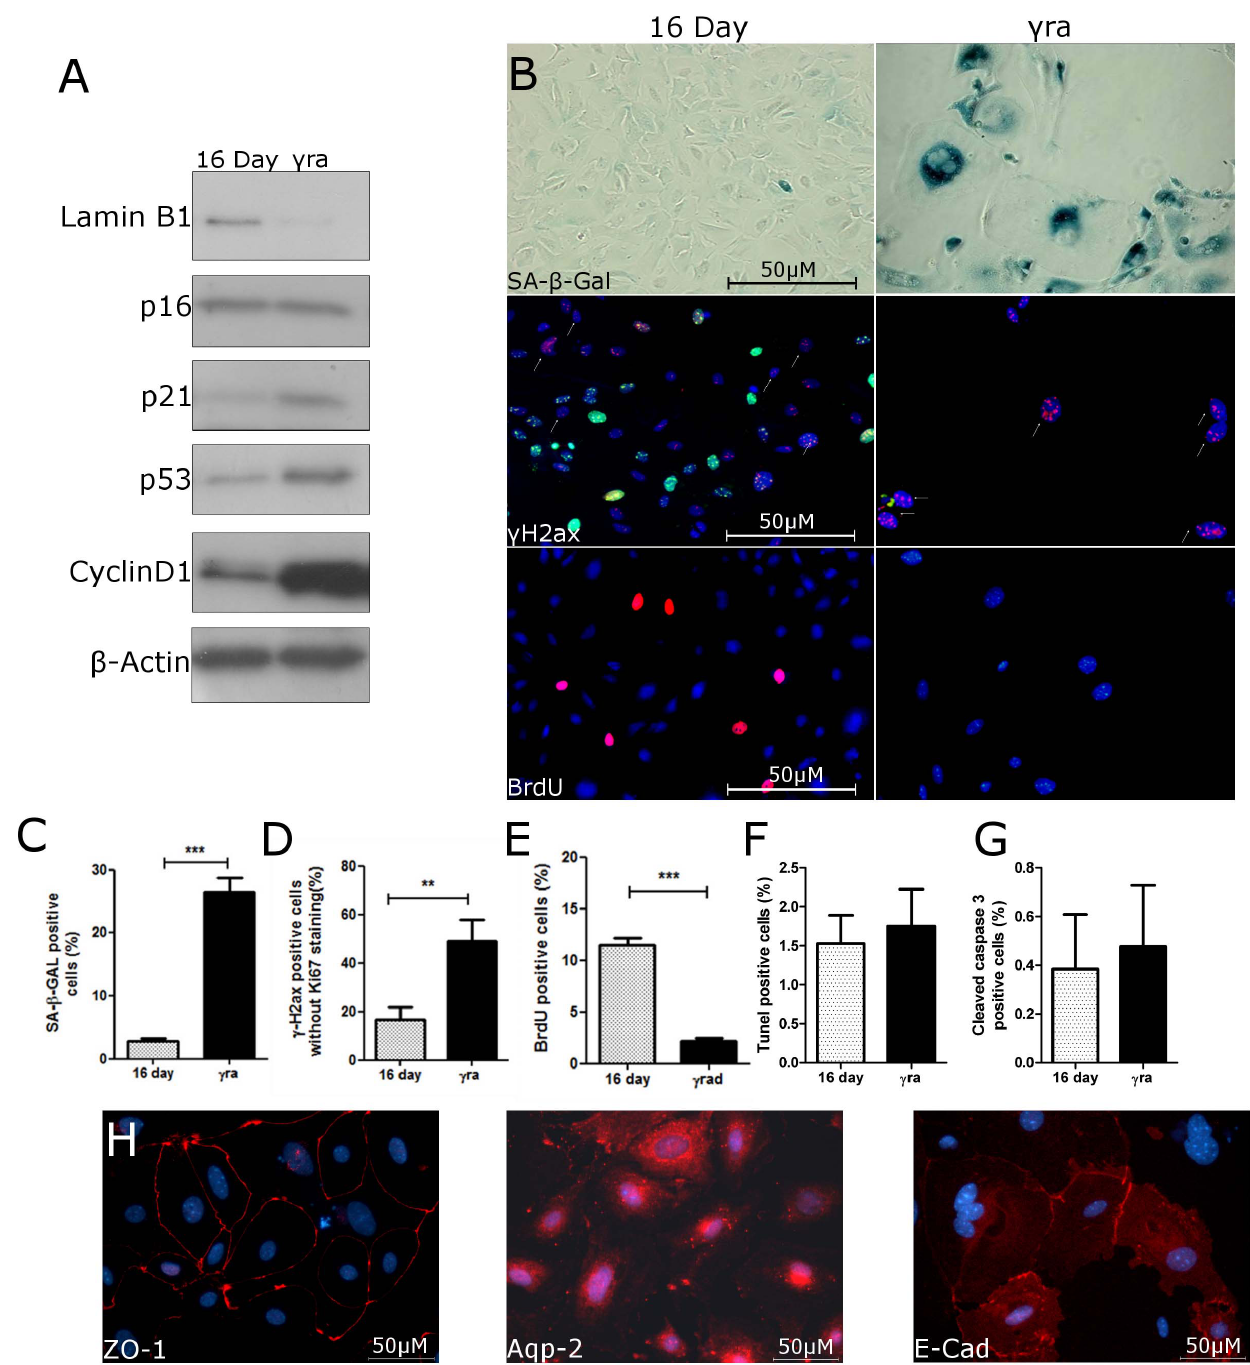
Figure 6. c -irradiation induces senescence in PTEC and leads to increased Cyclin D1 expression. PTEC were isolated and grown for 6 days in culture before being exposed to 10 Gy c -irradiation. After y-irradiation, cells were split and grown for 10 days and tested for senescence markers. Controls were grown for 6 days, split and grown for another 10 days. (A) Representative immunoblots for Lamin B1 and cell cycle regulators p16 INK4a , p21, p53, and Cyclin D1. (B) Representative photographs of SA- b -Gal, c H2AX and BrdU; original magnification 400 6 . Quantification of (C) SA- b -Gal, (D) c H2AX + /Ki-67 2 , (E) BrdU, (F) TUNEL, and (G) cleaved caspase 3 positive cells in cultures of control and c -irradiated PTEC. (H) Representative photographs of epithelial markers ZO-1, Aqp-2, and E-Cadherin in c -irradiated PTEC; original magnification 400 6 . Data are mean values 6 SEM. **P , 0.01; ***P , 0.001. doi:10.1371/journal.pone.0088071.g006 oncoprotein ras in human primary fibroblasts where there is an sudden lack of surrounding cell types and extracellular matrix induction of hyper-proliferation followed by premature senescence components, together with abnormal concentrations of nutrients, [33]. Furthermore, an artificial environment which includes the growth factors and oxygen may lead to a ‘culture shock’ [34]. This